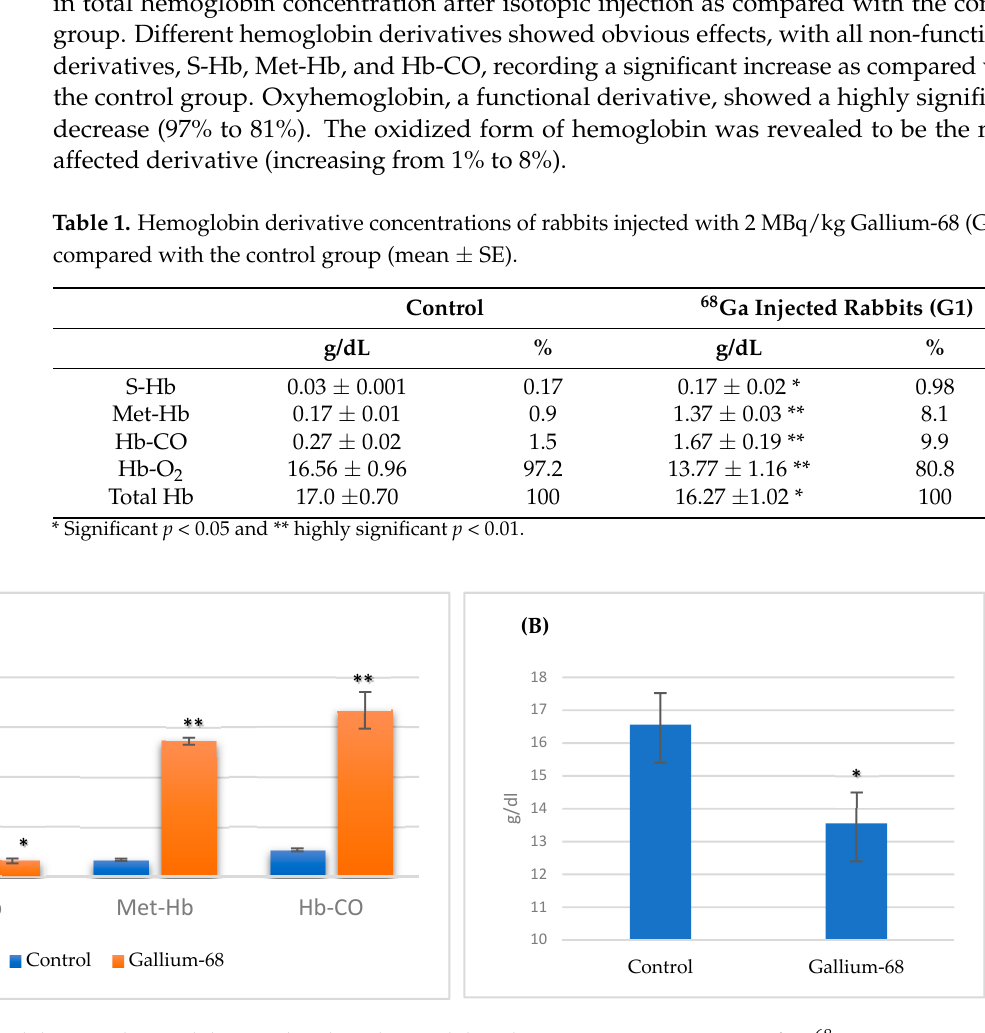
Figure 1. ( A ) Sulfhemoglobin, methemoglobin, and carboxyhemoglobin derivative concentrations after 68 Ga injection as compared to control. ( B ) Oxyhemoglobin derivative concentration after 68 Ga injection as compared to control. * Significant p < 0.05 and ** highly significant p < 0.01.